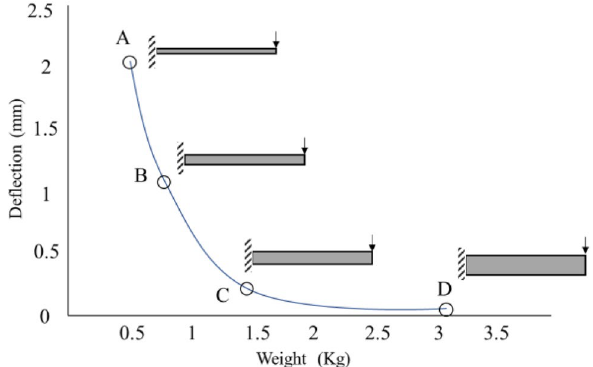
Figure 1. Pareto front for MOO of a beam with minimum deflection and minimum weight 31